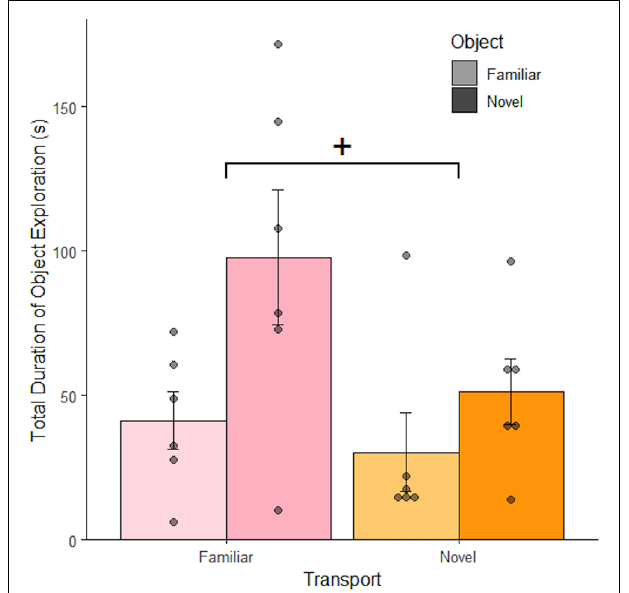
FIGURE 3 | Object exploration increased with novel objects and familiar transportation. Rats exposed to a novel object spent more time exploring it than rats exposed to a familiar object 1 h after the final object familiarization session. The introduction of novel transportation cues lead to a decrease in the mean total amount of time rats spent exploring the object; demonstrating that they were instead exploring the context ( n = 24). Error bars report SEM for each group. Points indicate the total duration of object exploration for each subject grouped into bins of 5.5 s. + p < 0.1.